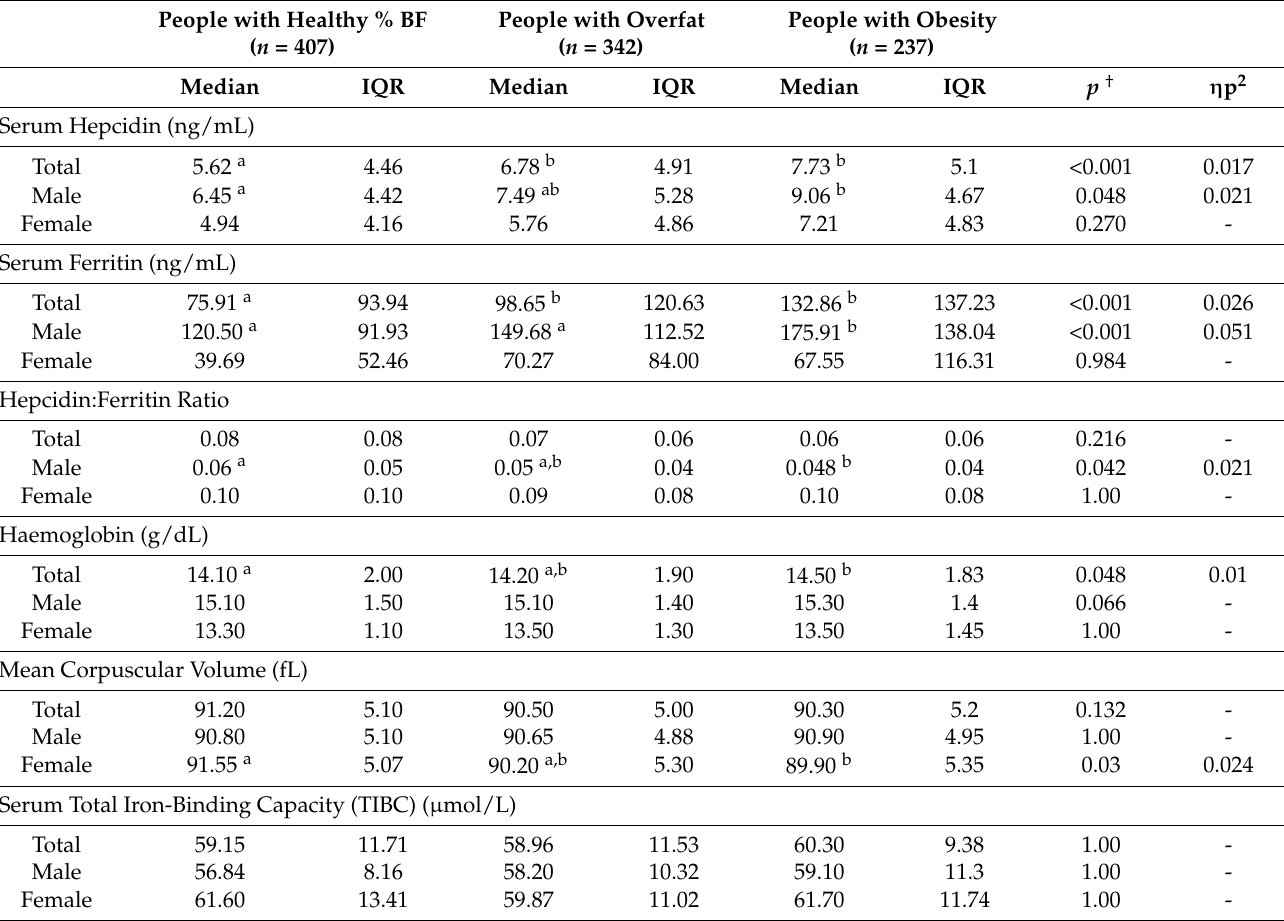
Table 2. Iron biomarkers across categories of % body fat.